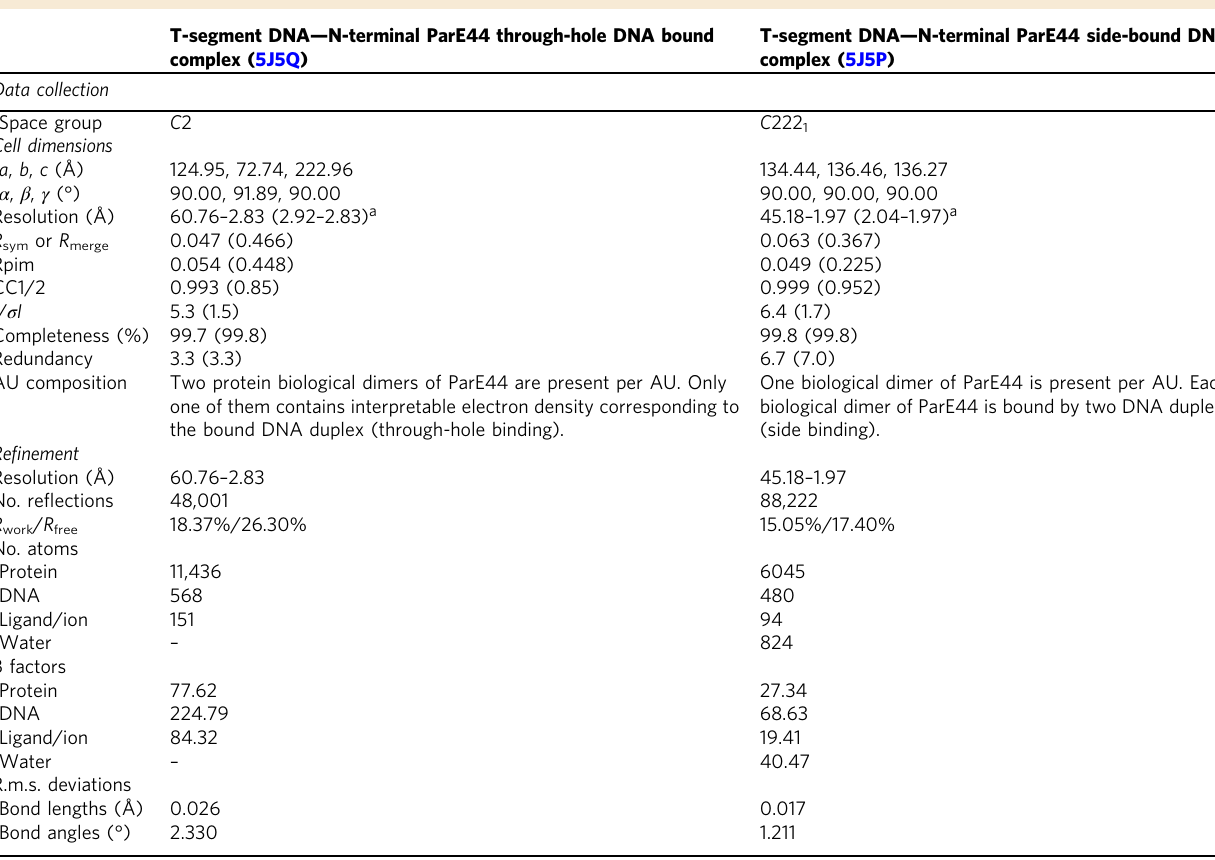
Table 1 Data collection and re fi nement